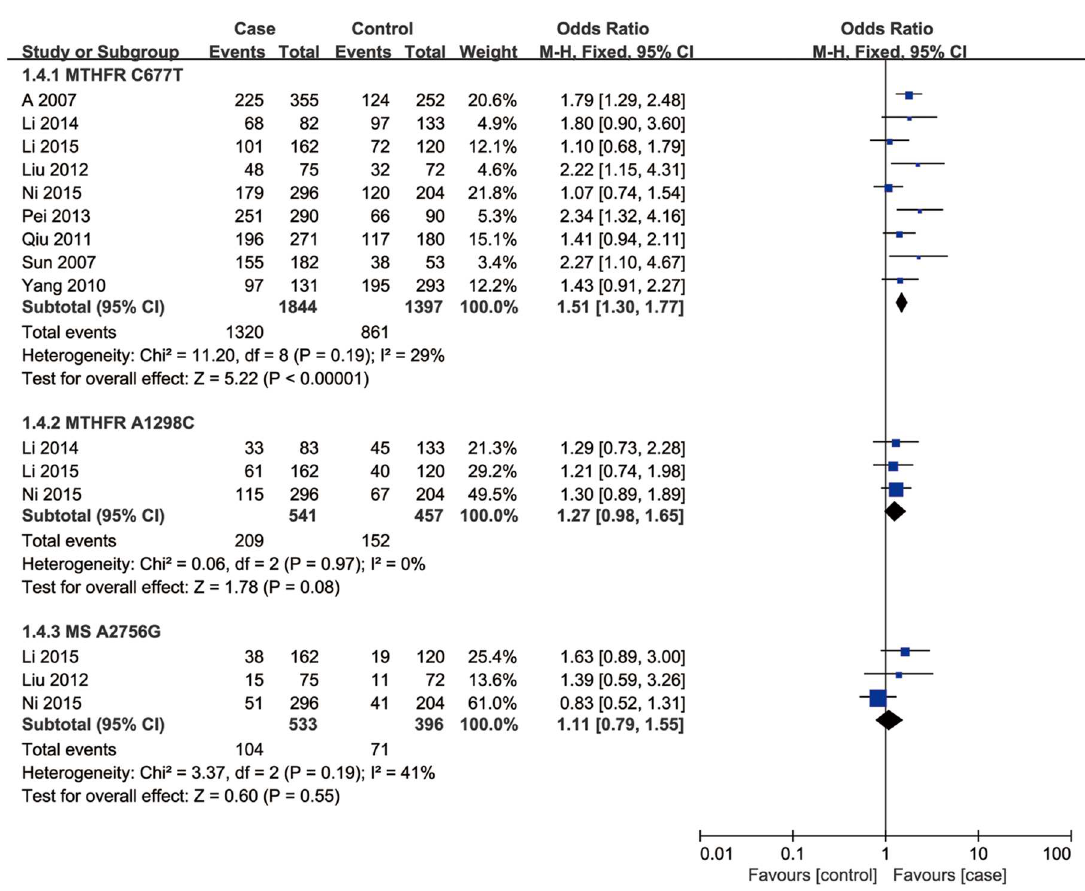
Fig 3. Forest plot of the studies assessing the association between MTHFR C677T, MTHFR A1298Cand MS A2756G polymorphisms and male infertility. (dominantmodel: (a) TT+CT vs. CC, (b) CC+AC vs. AA, (c) GG +AG vs.